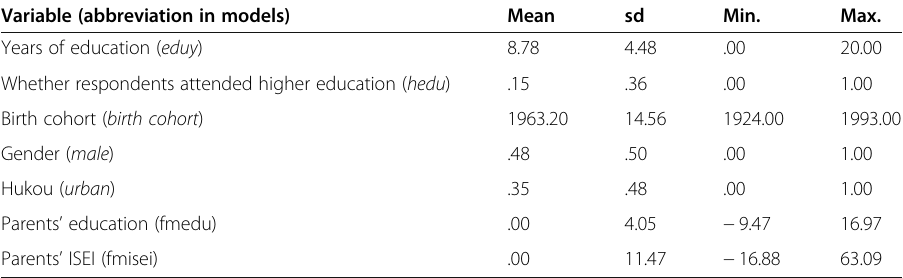
Table 1 Descriptive statistics for all variables ( N = 35,400) Variable (abbreviation in